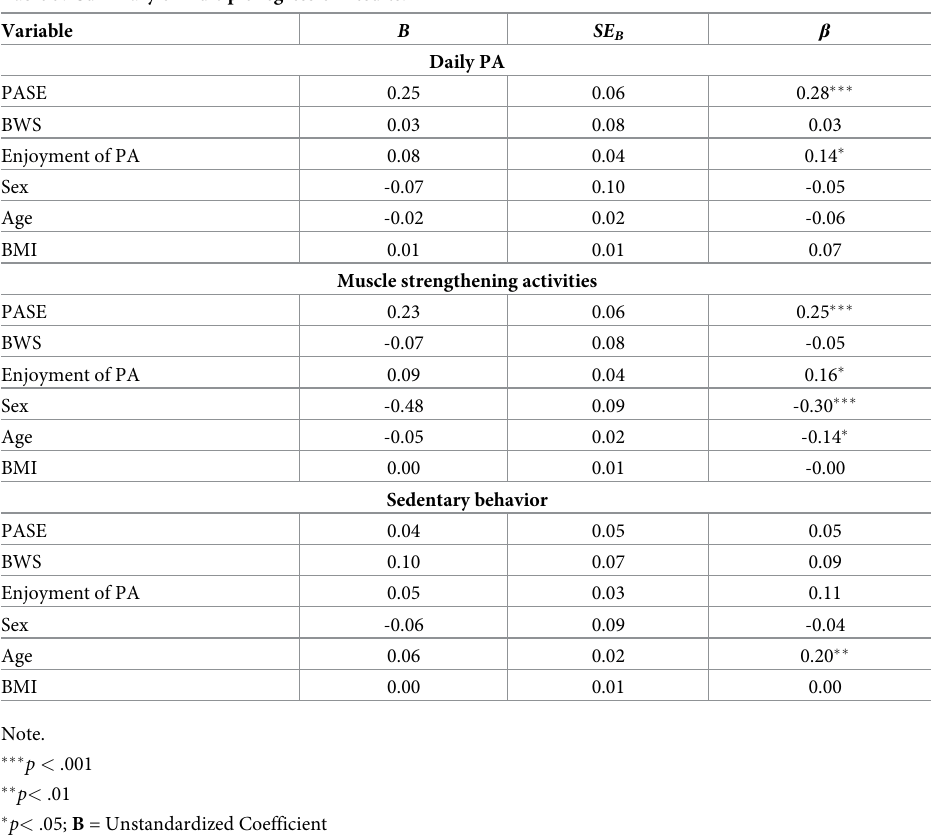
Table 3. Summary of multiple regression